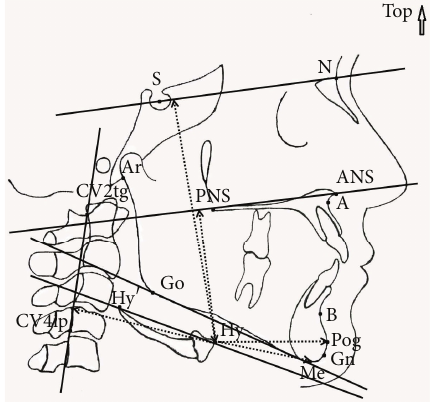
Figure 1: Angular and linear measurements used.